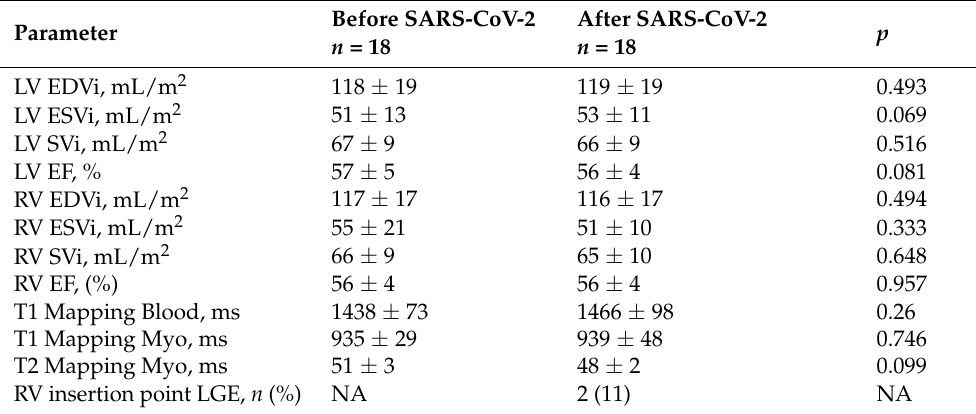
Table 4. CMR finding before and after SARS-CoV-2